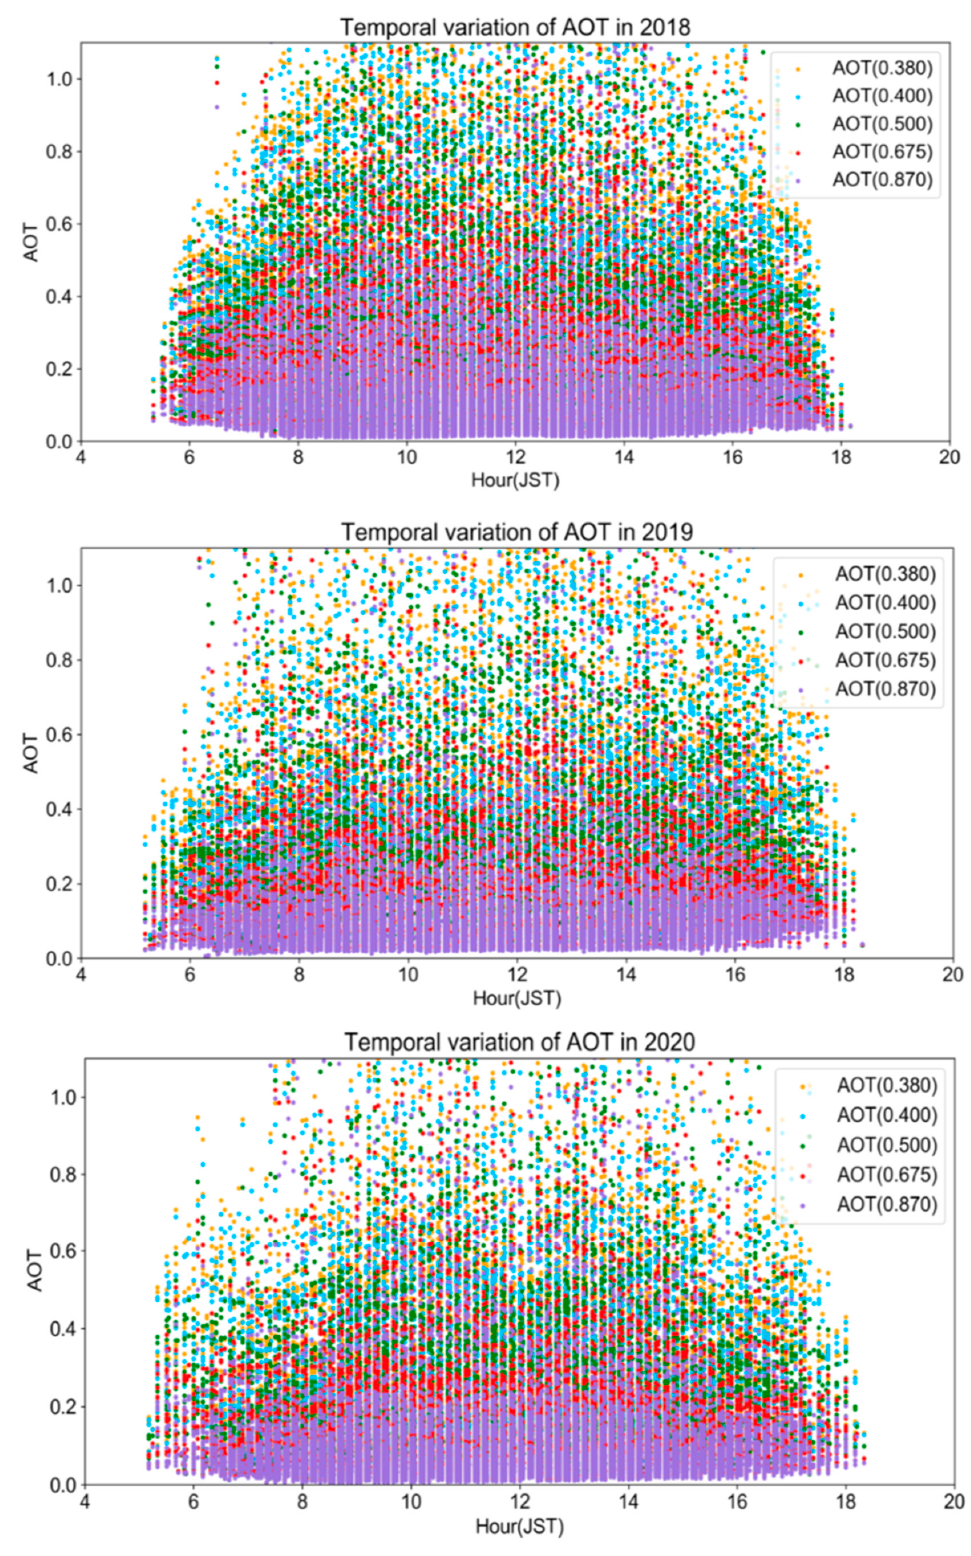
Figure 12. Temporal variation of AOTs observed with the sky-radiometer from various wavelengths (data are from 2018, 2019, and 2020,